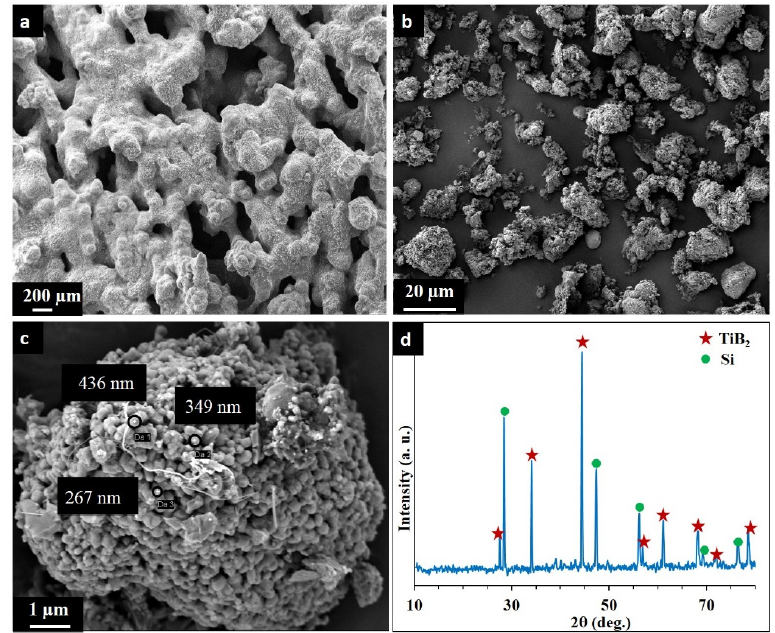
Figure 2. Scanning electron microscope (SEM) images of porous bulk TiB 2 -Si product produced by SHS ( a ), the TiB 2 -Si powder after milling ( b and c ), and the X-ray diffraction (XRD) pattern of the combustion product ( d ).